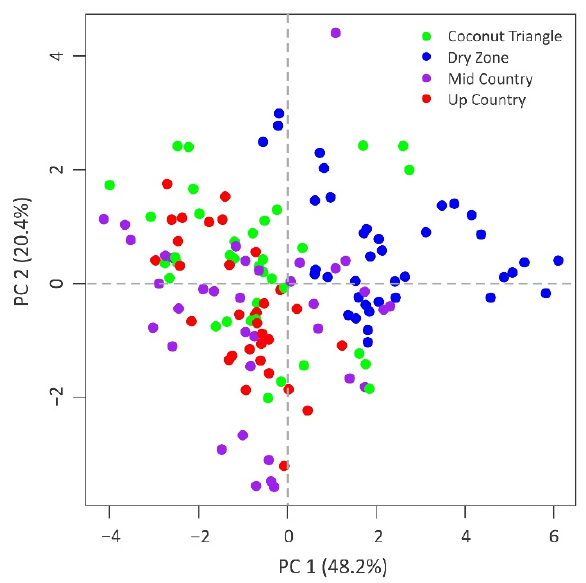
Figure 5. Scatter plot of the PC-1 and PC-2 based on the principal components analyses of stable isotopes ratios. Table 5. The numbers of samples correctly assigned to the agroclimatic zones by the LDA analysis of stable isotope ratios. Numbers in parentheses provide the cross-validation results of the same using leave-one-out cross-validation method.